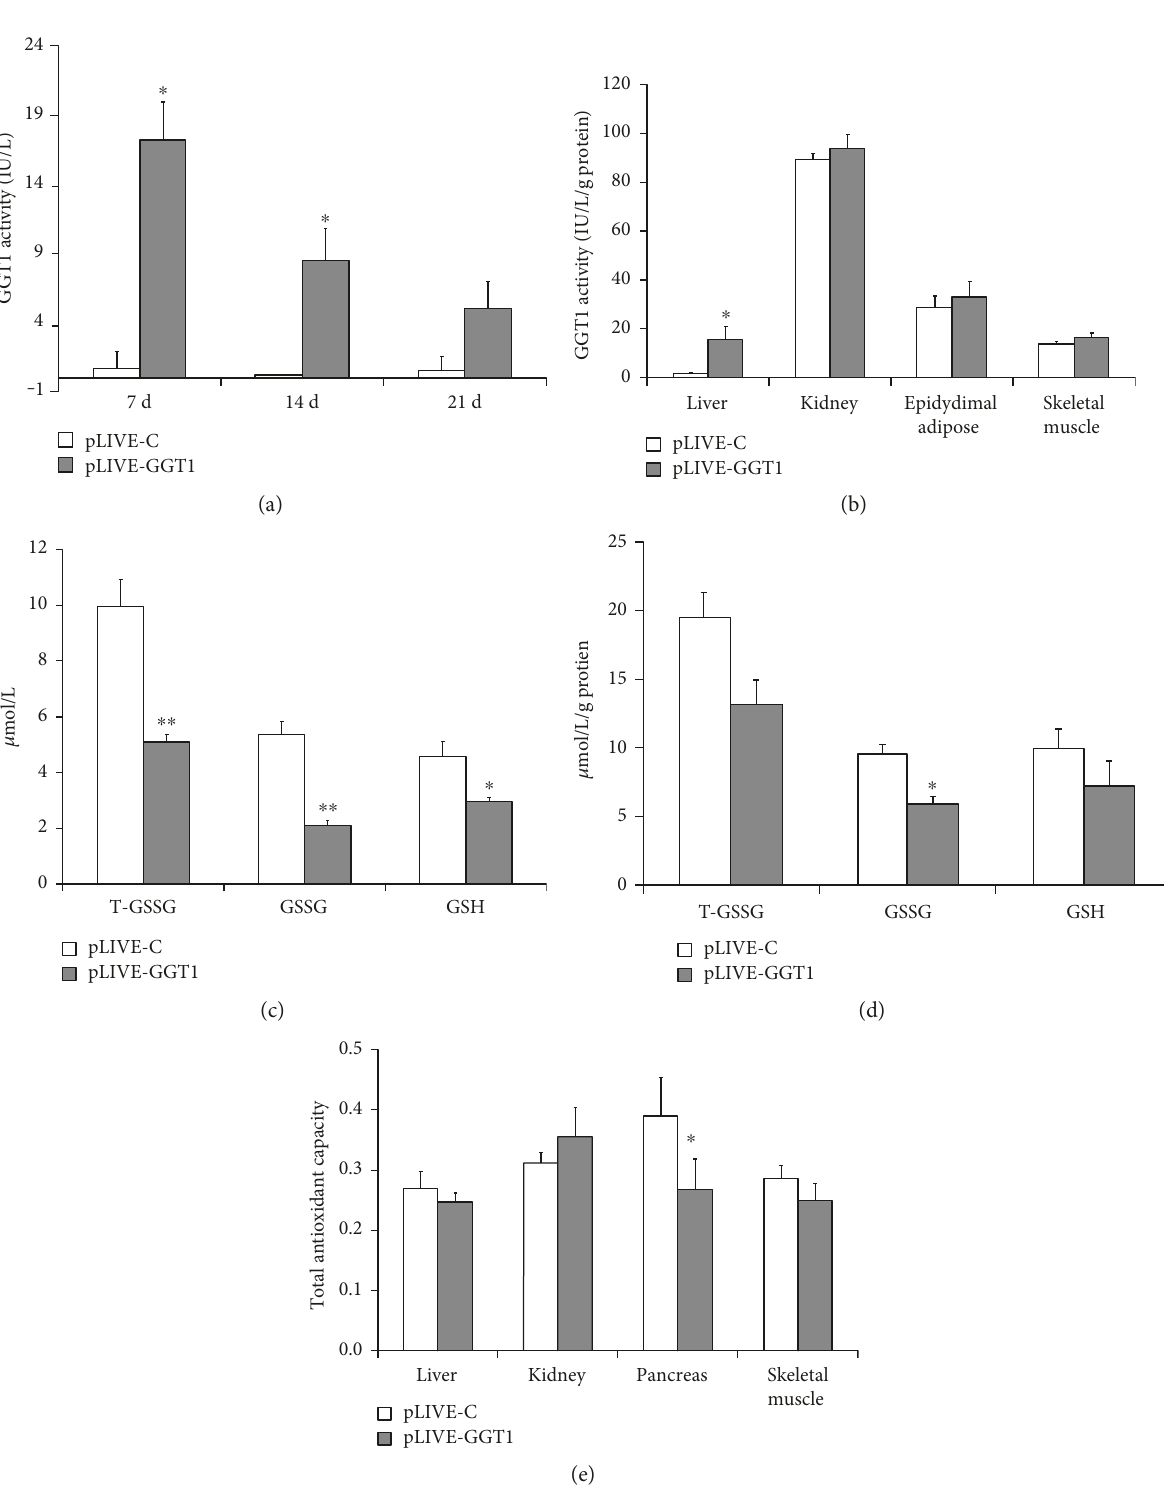
Figure 2: Generation of liver-speci fi c GGT1-overexpressing mice. (a) Serum GGT activities on 7, 14, and 21 days after plasmid delivery through tail vein injection. (b) GGT activities in the liver, kidney, skeletal muscle, and pancreas on the 14 days after plasmid delivery. (c) The concentrations of T-GSSG, GSSG, and GSH in serum. (d) The concentrations of T-GSSG, GSSG, and GSH in liver homogenates. (e) The levels of total antioxidant capacity in the liver, kidney, pancreas, and skeletal muscle. ∗ P < 0 05 , ∗∗ P < 0 001